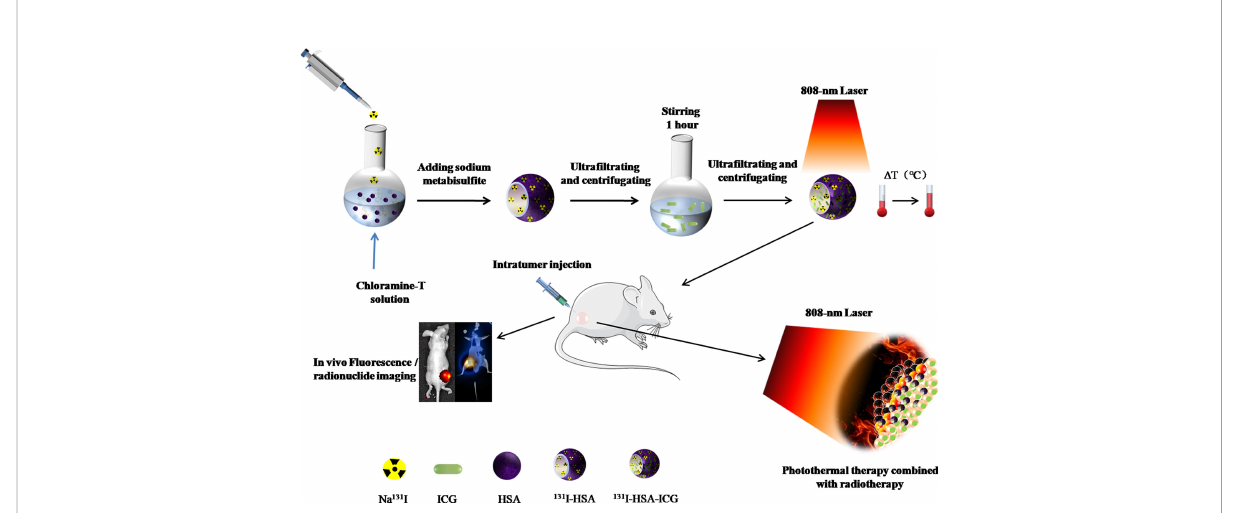
FIGURE 1 Schematic illustration of synthesized 131 I-HSA-ICG nanoparticles for bimodal imaging and therapy of anaplastic thyroid cancer. HSA, human serum albumin; ICG, indocyanine